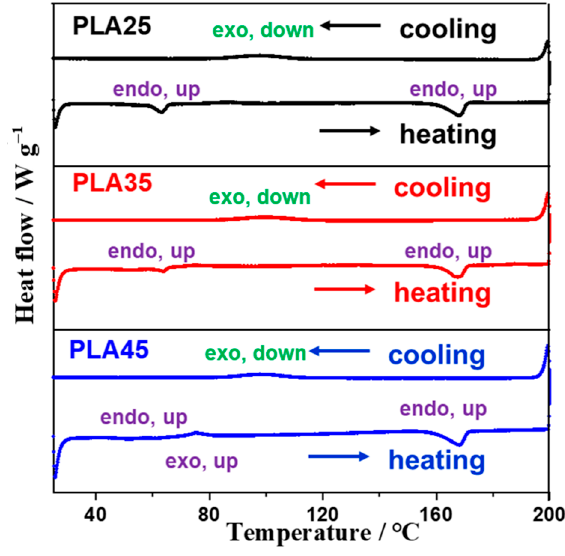
Figure 4. DSC curves of the three electrospun/electrosprayed PEG/PLA films.